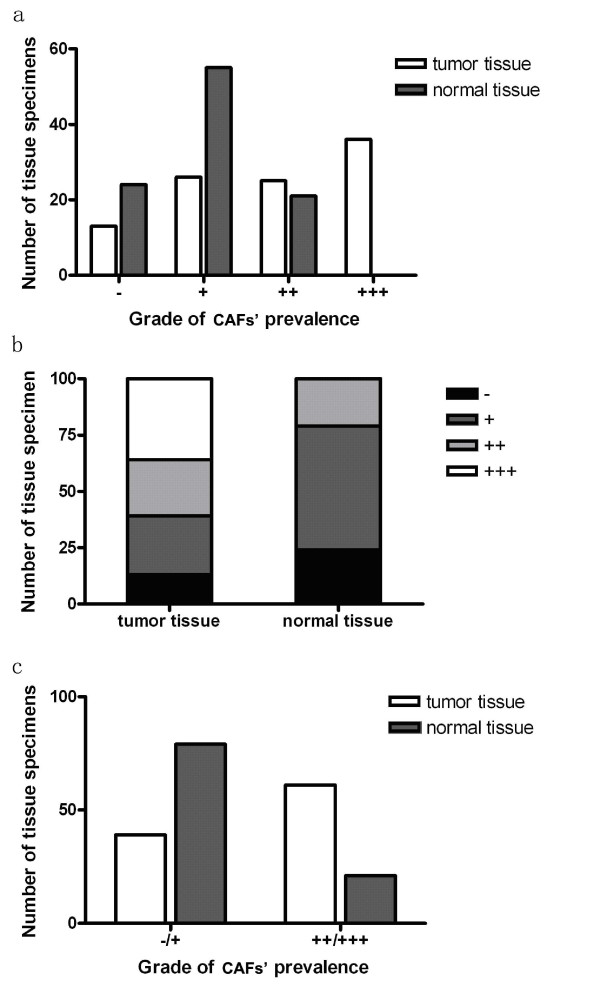
Immunochemistry analysis of the grade of CAFs' prevalence in tumor and normal gastric tissues. Paraffin sections of surgically resected tumor and normal tissues from the same gastric cancer patients (100 cases) were stained for FSP1, α-SMA and procollagen-1 expression and CAFs prevalence was graded according to the positive rate and intensity of the immunochemical staining. The number of tumor or normal tissue specimens graded as -, +, ++ and +++ was compared (a). And the distribution of these four grades of CAFs' prevalence in the 100 tumor or normal tissue specimens were analyzed (b). Grade - and + was regarded as negative, while grade ++ and +++ was regarded as positive for CAFs prevalence, then the number of the tumor or normal tissue specimens which was positive or negative for CAFs' prevalence was compared (c).